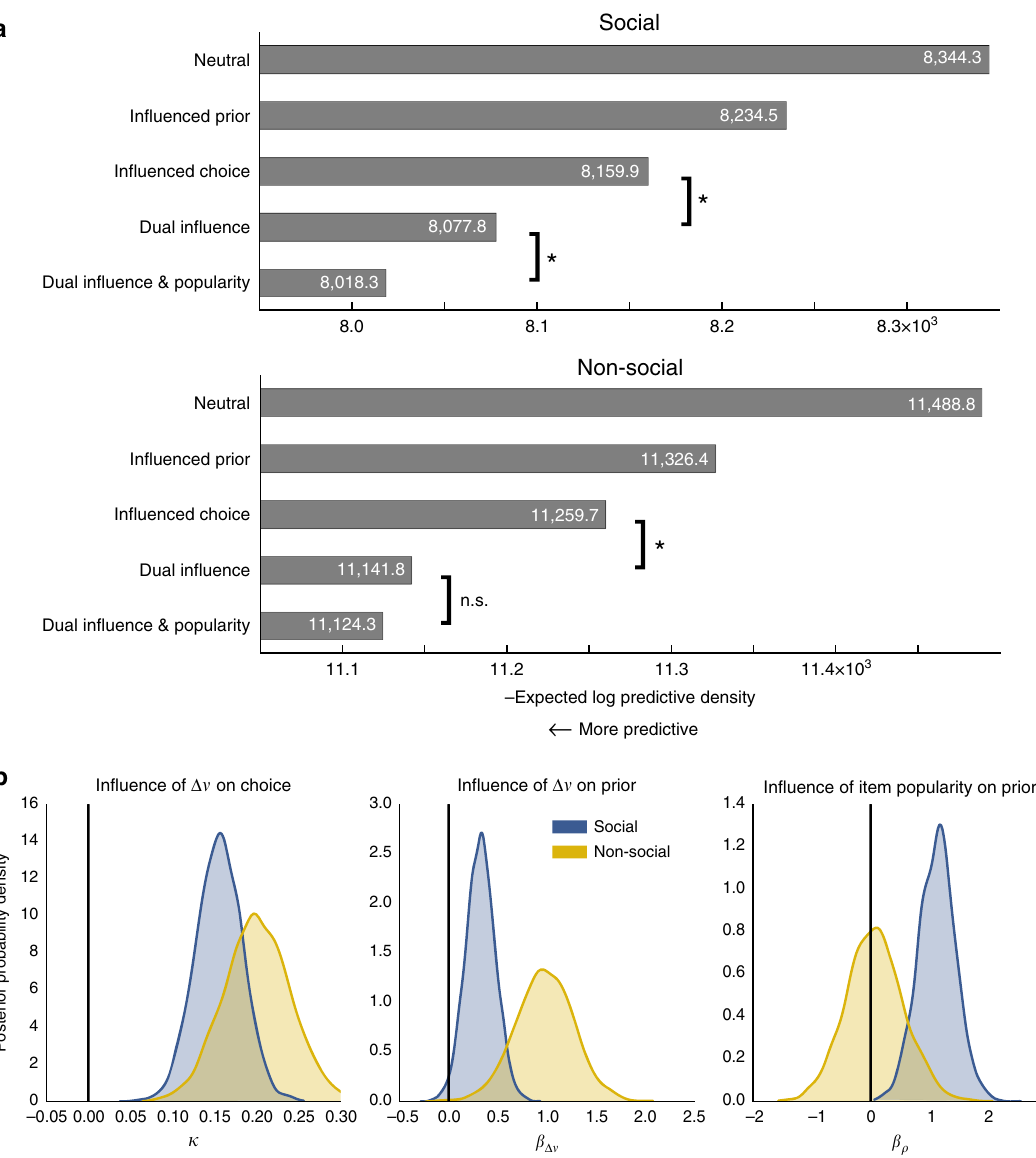
Fig. 6 Computational model results. a Negative estimated log predictive density of the fi ve models fi tted to both social and non-social groups (lower means more predictive). * P < 0.05, two-tailed. b Group mean parameter estimates for the preference and item popularity weight terms in the dual in fl uence model with item popularity, shown for both social ( blue ) and non-social ( gold ) groups. Values greater than 0 indicate a mean positive effect while values less than 0 would indicate a negative effect. Distributions show the uncertainty in the parameter estimates of the group means and are kernel density smoothed. While preference positively affects priors and choice processes in both groups, item popularity affects priors only in the social